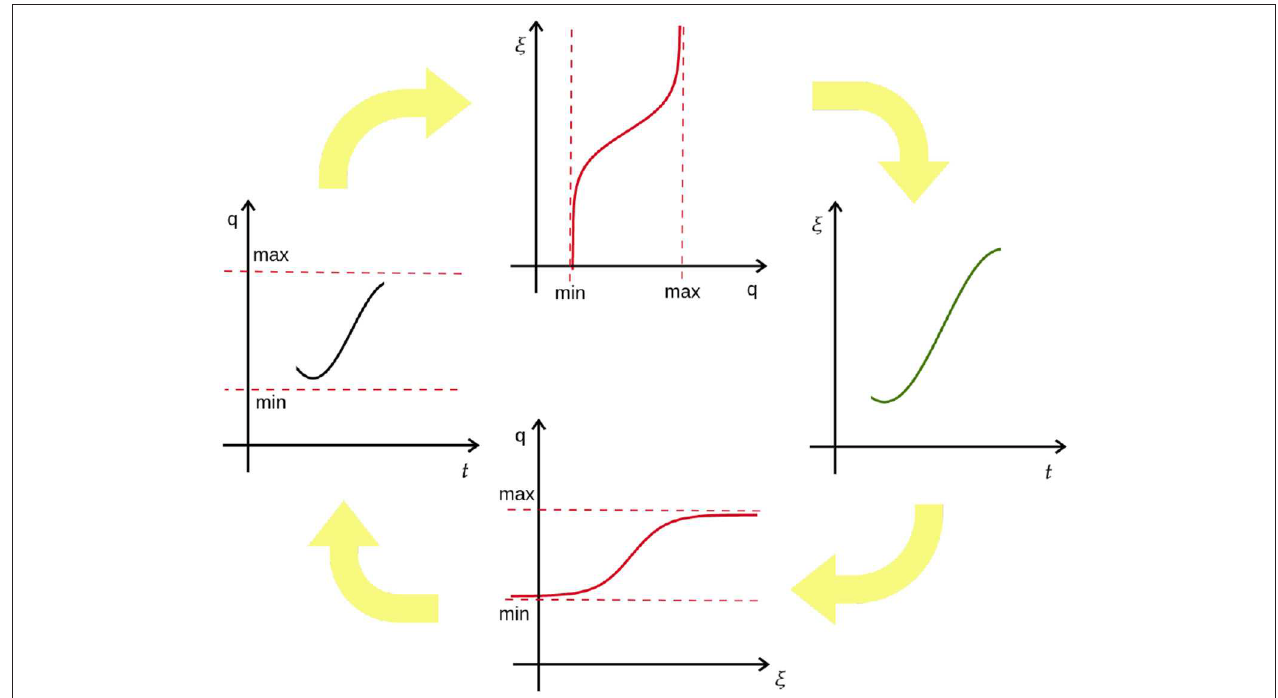
FIGURE 3 | Illustration of the principle of CDMPs. Joint trajectory q is first transformed into the exogenous state ξ using the arctangent hyperbolic function and then transformed back using the hyperbolic tangent function. Trajectory modifications are done in tanh -space.